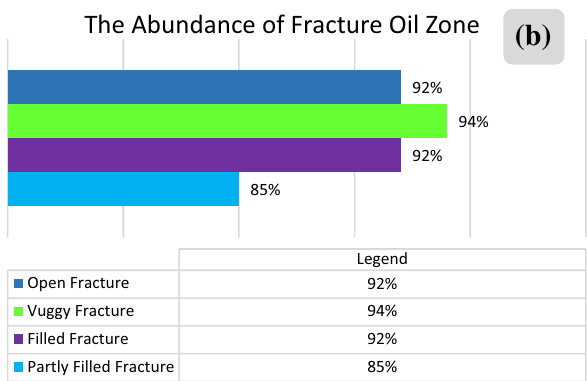
Fig. 5 Abundance of fractures: A in Sarvak Formation of studied well (2791–3415 m) and B in oil-producing zone of studied well (3791–3000